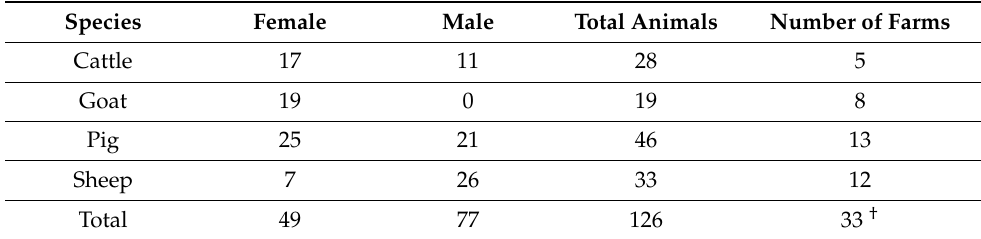
Table 1. Characteristics of livestock sampled (n = 126) for leptospirosis in St. Croix, U.S. Virgin Is-